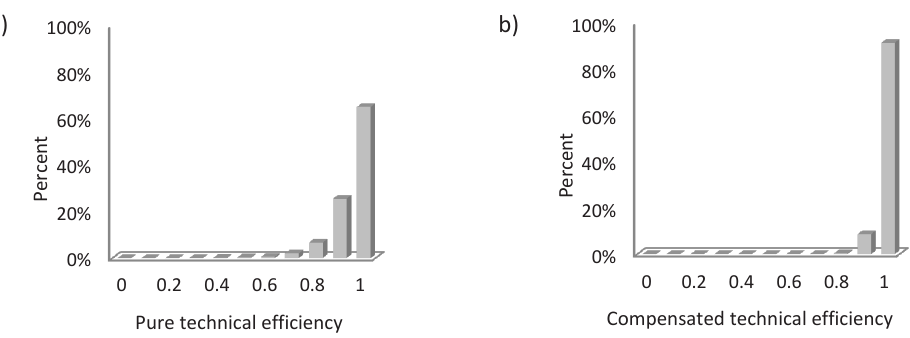
Fig. 1. Distributional graphs of (a) pure technical efficiency and (b) compensated technical